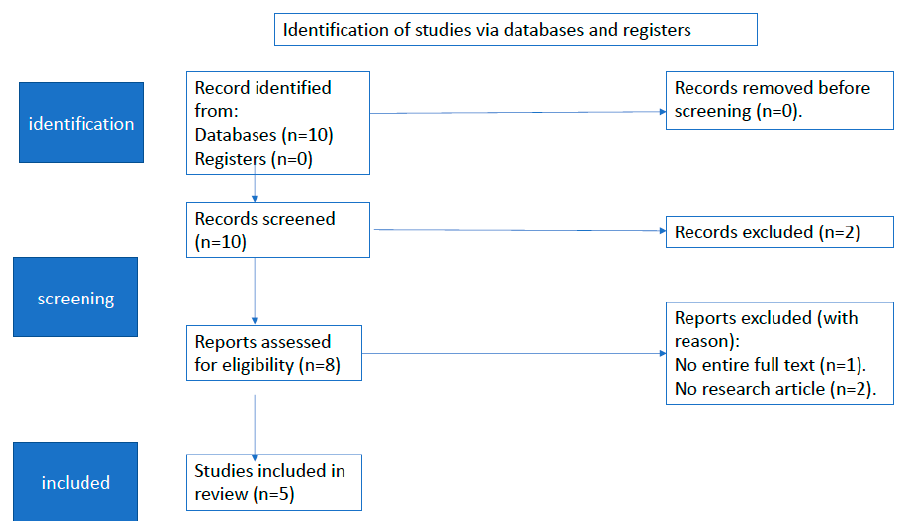
Figure 1. Flow diagram of study selection for this review.